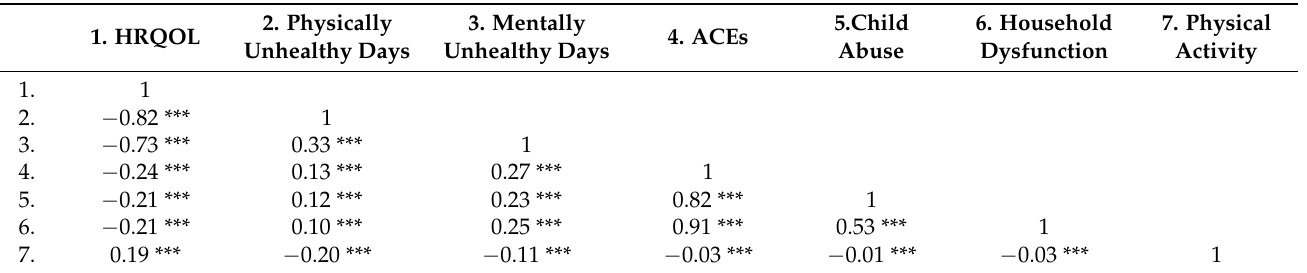
Table 3. Correlation matrix for continuous predictors, moderator, and outcome variables ( n =